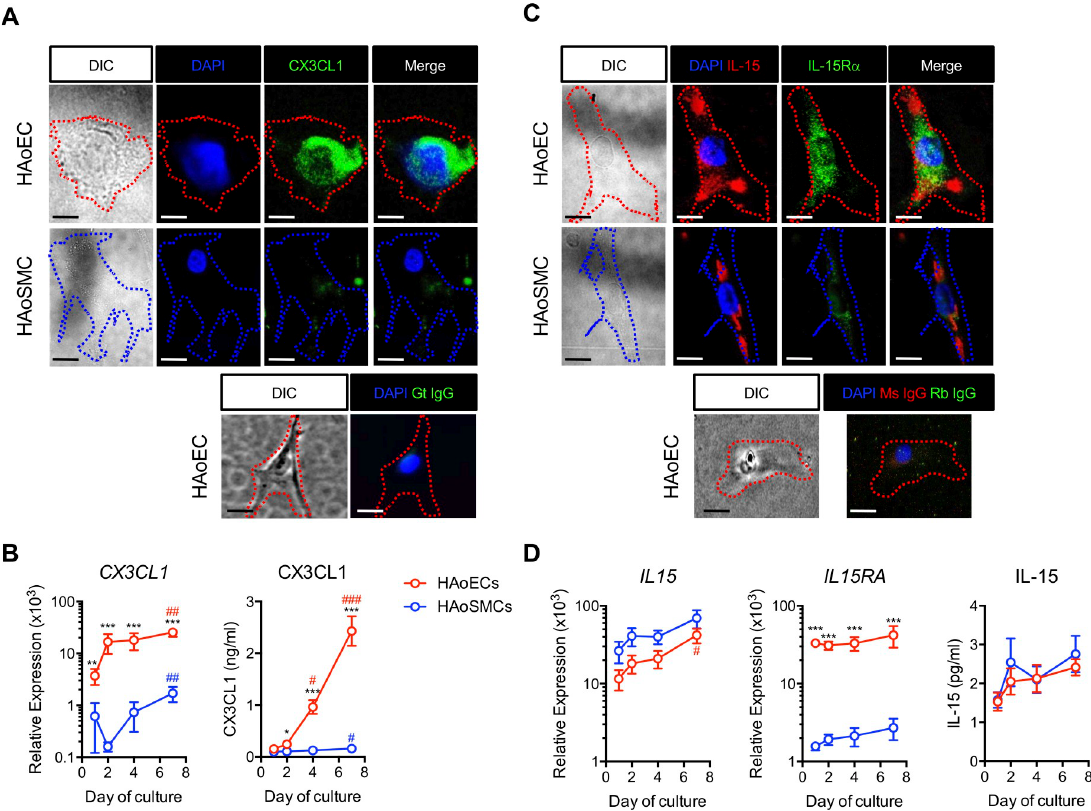
Fig 3. Differential expression of CX3CL1 and IL-15/IL-15R α by HAoECs and HAoSMCs. (A) CX3CL1 protein expression in HAoEC (upper row) and HAoSMC (lower row). (B) Relative CX3CL1 expression compared to GAPDH (left) and CX3CL1 secretion (right) in HAoECs (n = 8) and HAoSMCs (n = 8). (C) Constitutive surface expression of IL-15 and IL-15R α in HAoEC (upper row), and in HAoSMC (lower row). (D) Relative expression of IL15 and IL-15RA compared to GAPDH (left and middle) and IL-15 secretion (right) in HAoECs (n = 7) and HAoSMCs (n = 7). (B,D) Data are mean ± SEM. Differences between groups were determined by Mann-Whitney U test: � P � 0.05; �� P � 0.01; ��� P � 0.001. Differences within groups were determined by Kruskal-Wallis test with Dunn’s correction: # P � 0.05; ## P � 0.01; ### P � 0.001. HAoECs, human aortic endothelial cells; HAoSMCs, human aortic smooth muscle cells; DIC, differential interference contrast; Gt, goat; Ms, mouse; Rb,